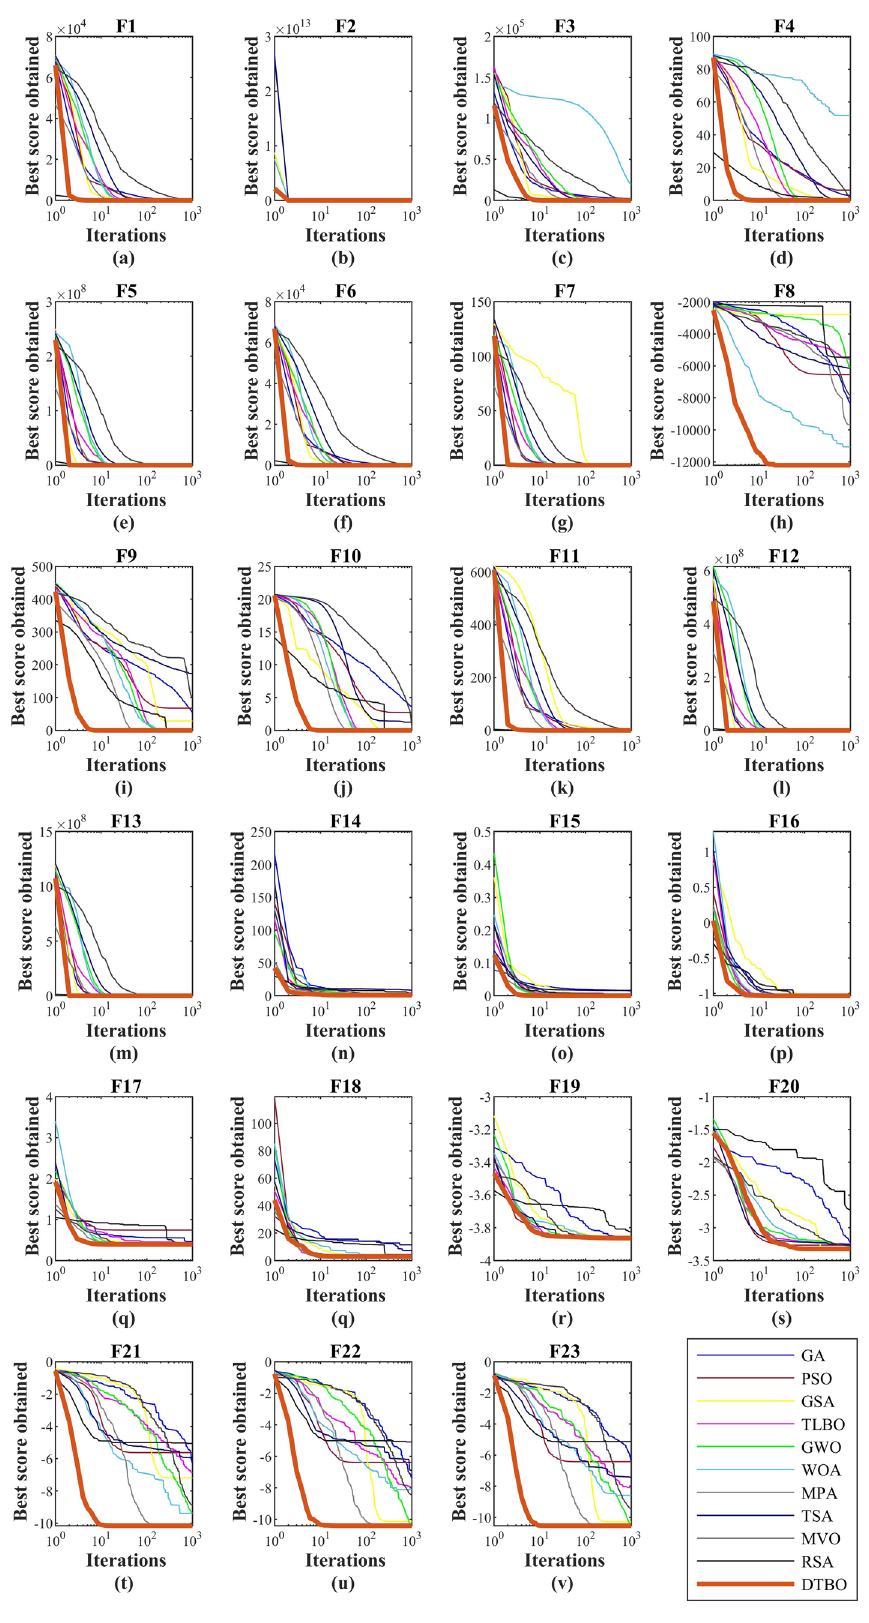
Figure 2. Convergence curves of DTBO and competitor algorithms in optimizing objective functions F 1 to F 23